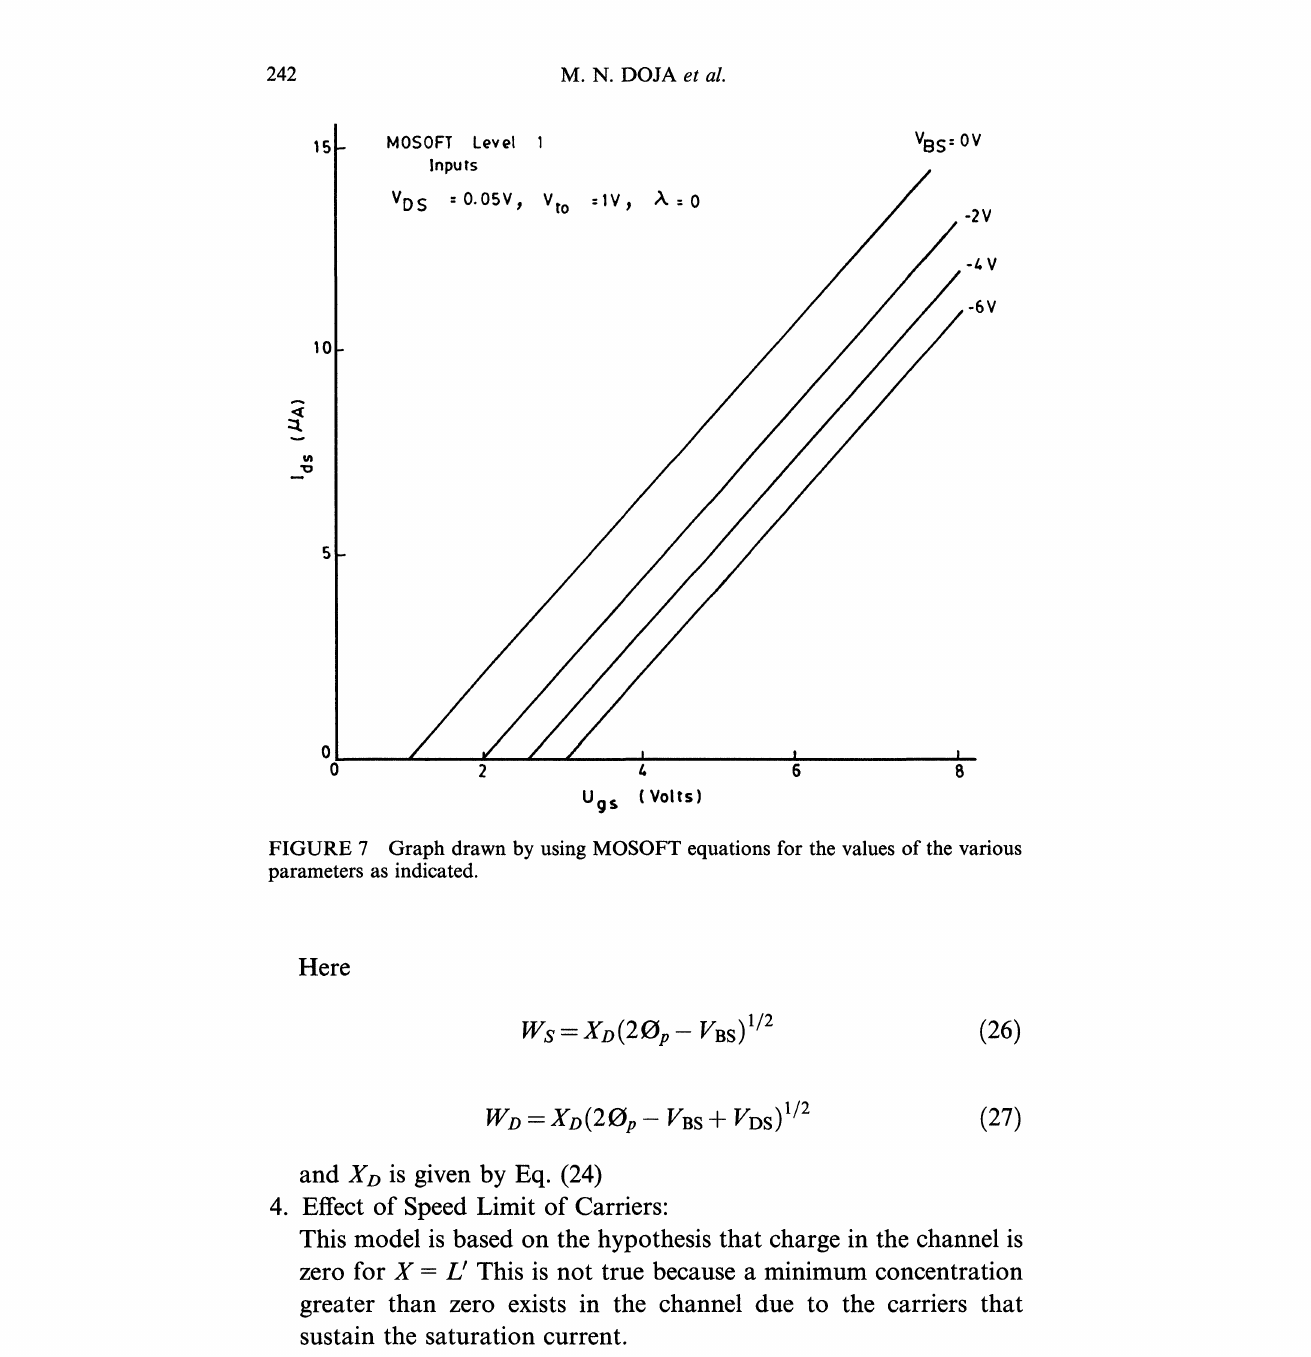
FIGURE 7 Graph drawn by using MOSOFT equations for the values of the various parameters as